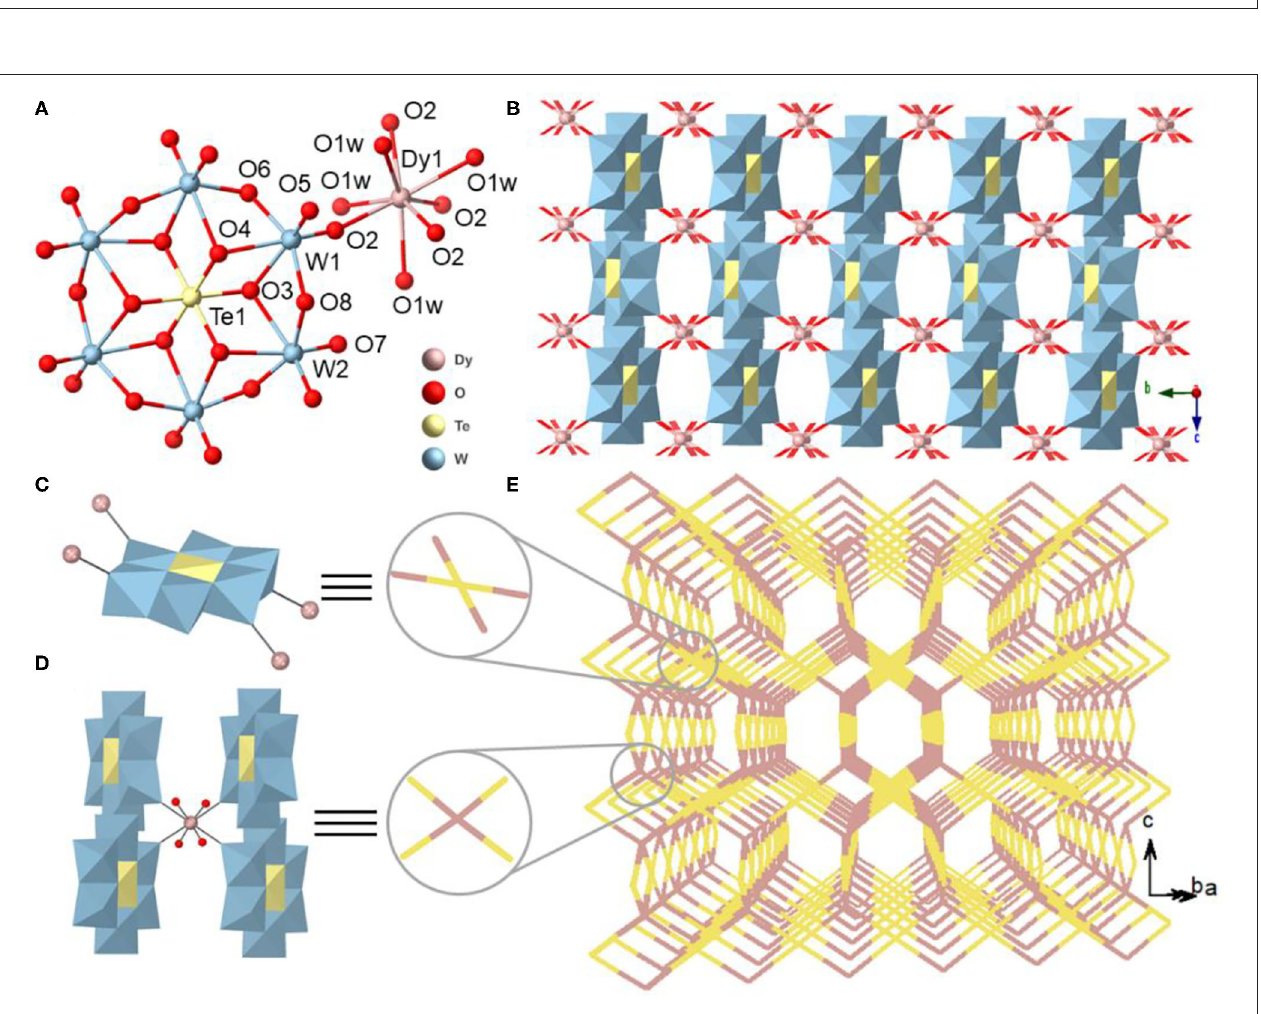
FIGURE 2 | (A) View of the coordination of an Anderson-type [TeW 6 O 24 ] 6 − polyanion to one hydrated Dy 3 + cation. (B) View of 3D inorganic structure of {DyTeW 6 } compound. Simplified view of (C) [TeW 6 O 24 ] 6 − polyanion and (D) Dy 3 + cation as the four-connecting sites. (E) 3D schematic illustration of {DyTeW 6 } (yellow: [TeW 6 O 24 ] 6 − polyanion; purple: Dy 3 + cation). The DMAH + cations and the lattice H 2 O molecules are omitted for clarity.